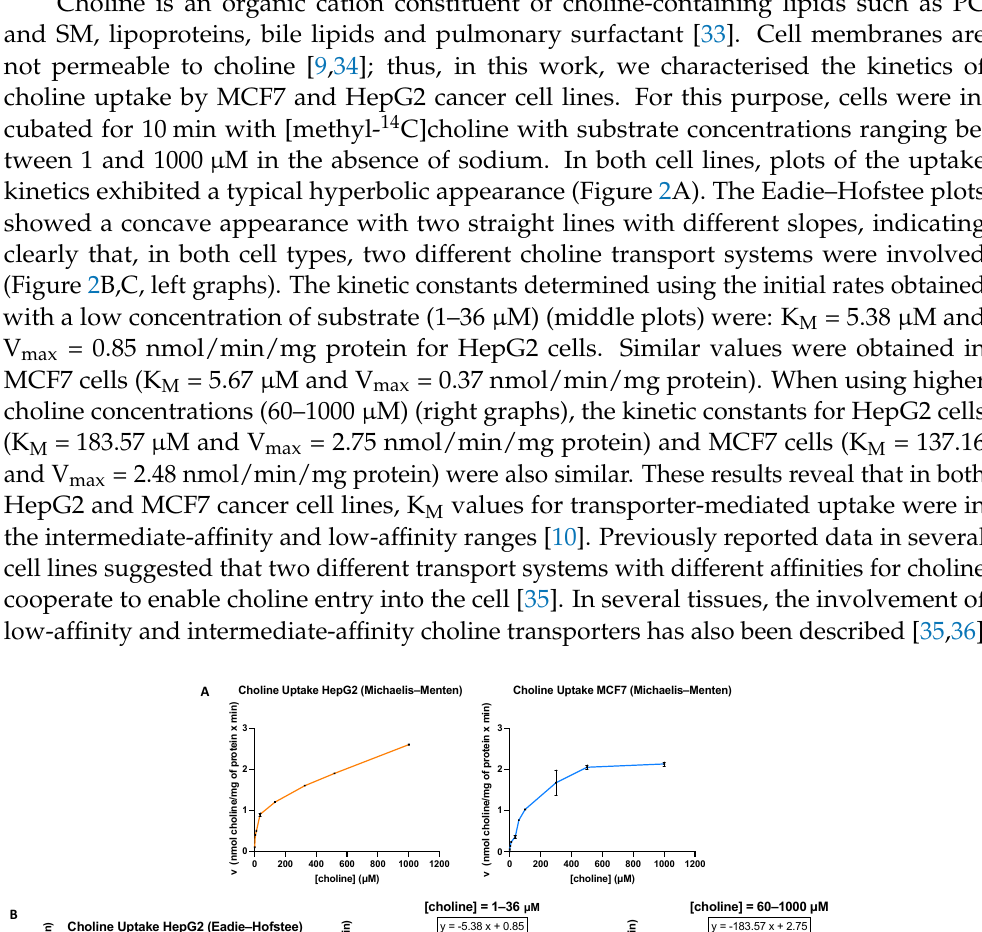
low-affinity and intermediate-affinity choline transporters has also been described [35,36].